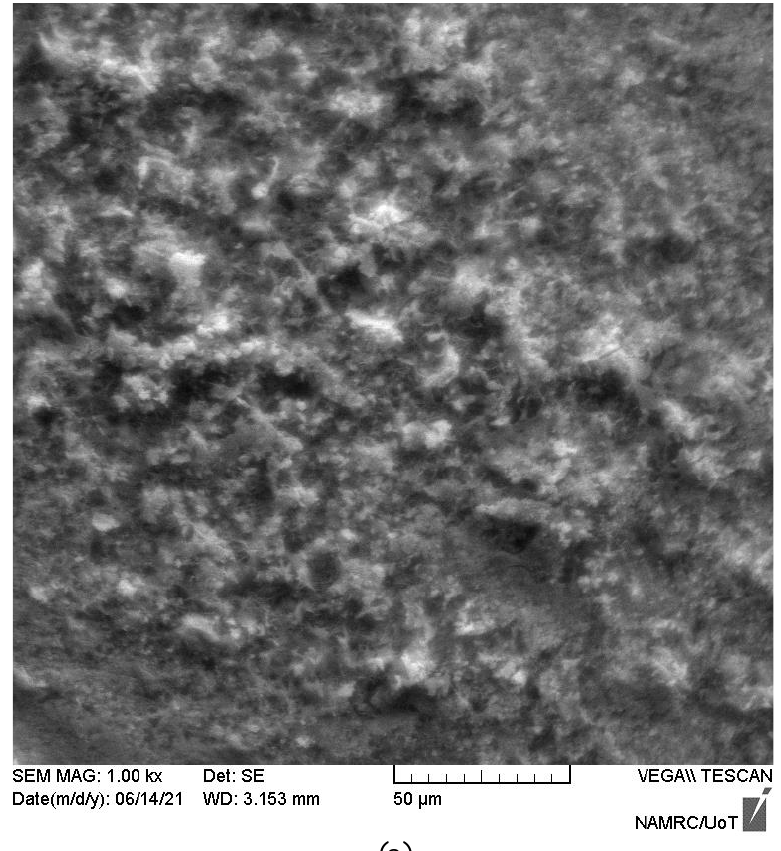
Figure 2(a): SEM image of 0.2gm/cm 3 of CdO thin film for